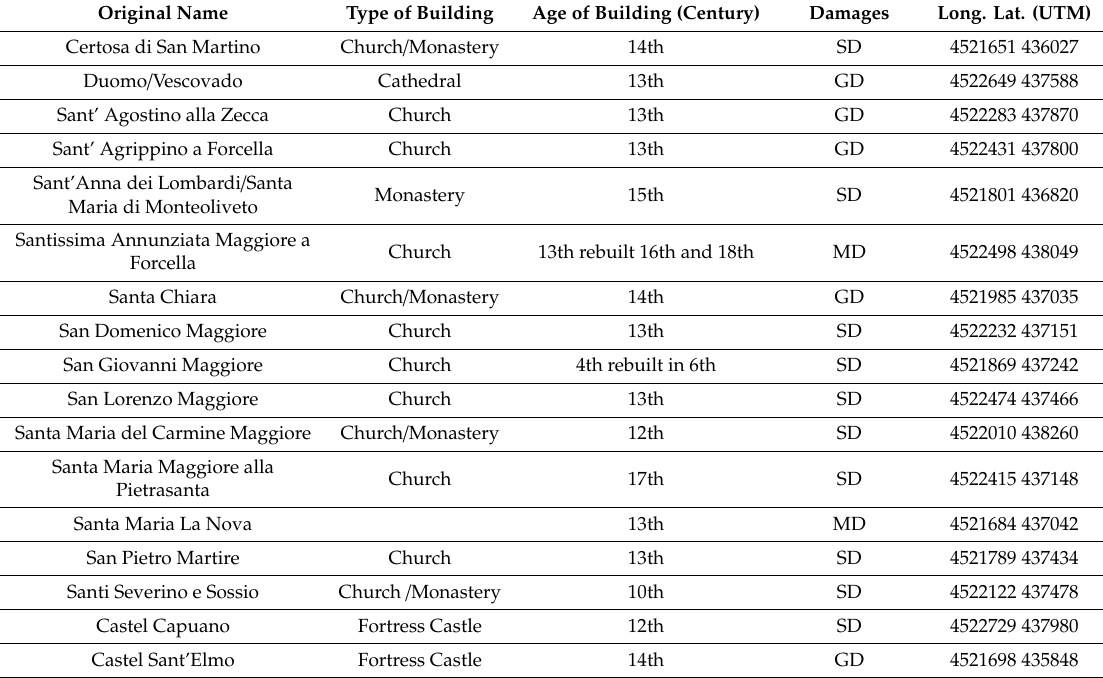
Table A2. The historical buildings of Naples damaged by the earthquake of 1456 [5,42]. MD = Minor Damage; SD = Serious Damage; GD = Great